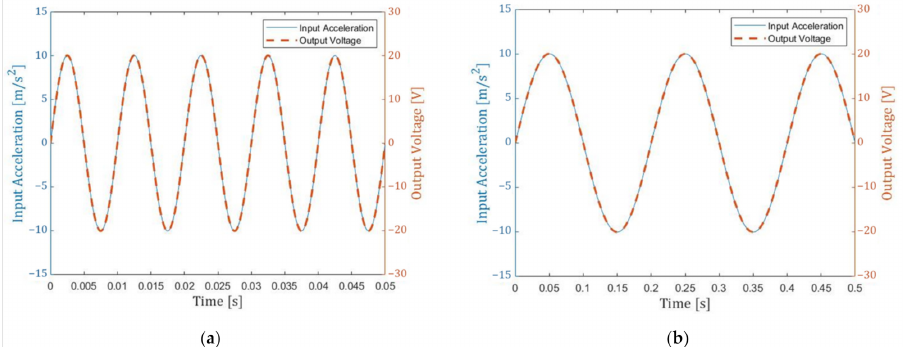
Figure 11. Simulation results of different acceleration input frequencies ( a ) 100 Hz (maximum frequency); ( b ) 5 Hz (typical frequency). The solid line corresponds to the input acceleration, and the dashed line corresponds to the output voltage. Matching of the two curves implies that the system can respond to the input accelerations. Results for lower frequencies are not shown because catching up to the input will become much